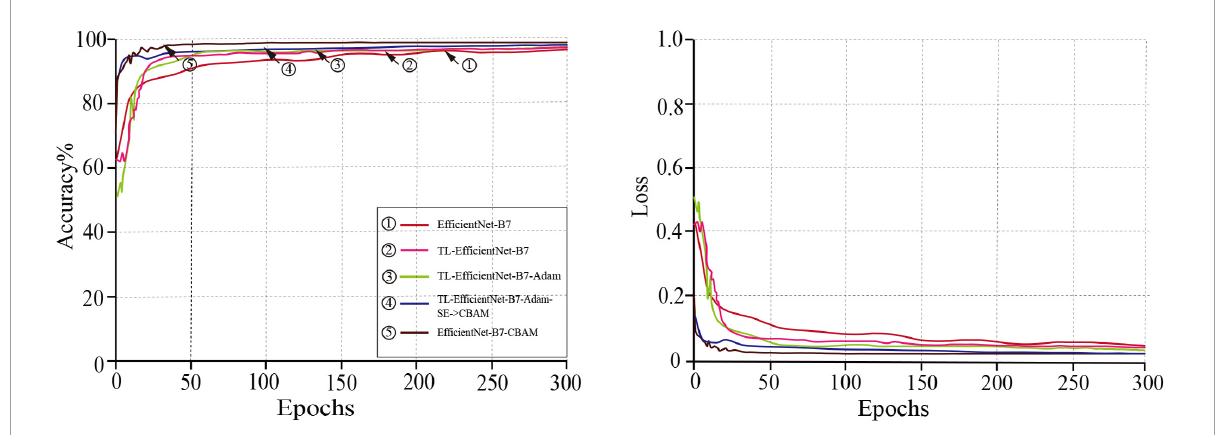
FIGURE11 The training curves of the